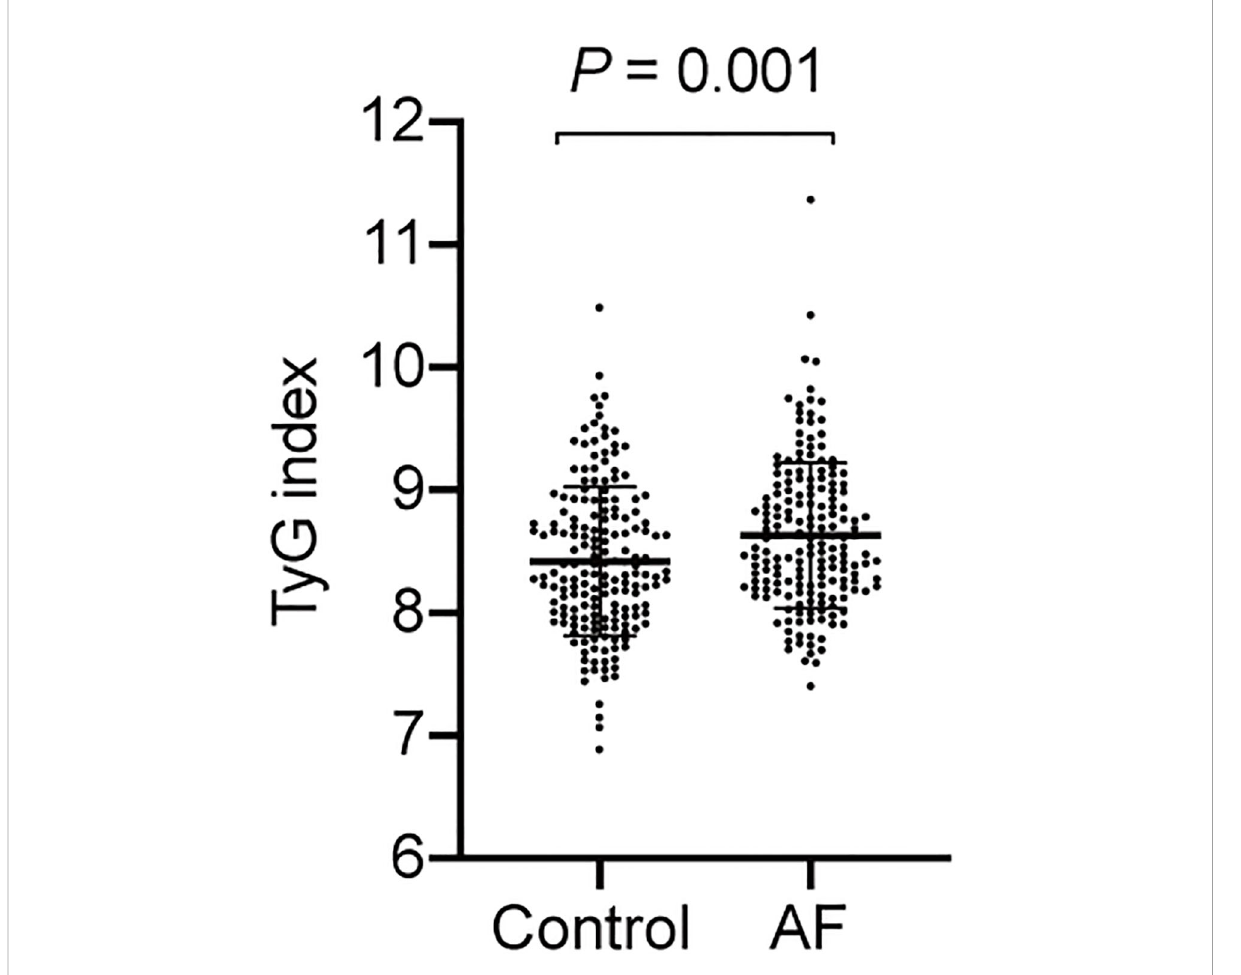
FIGURE 2 The TyG index in AF group and control ( P =